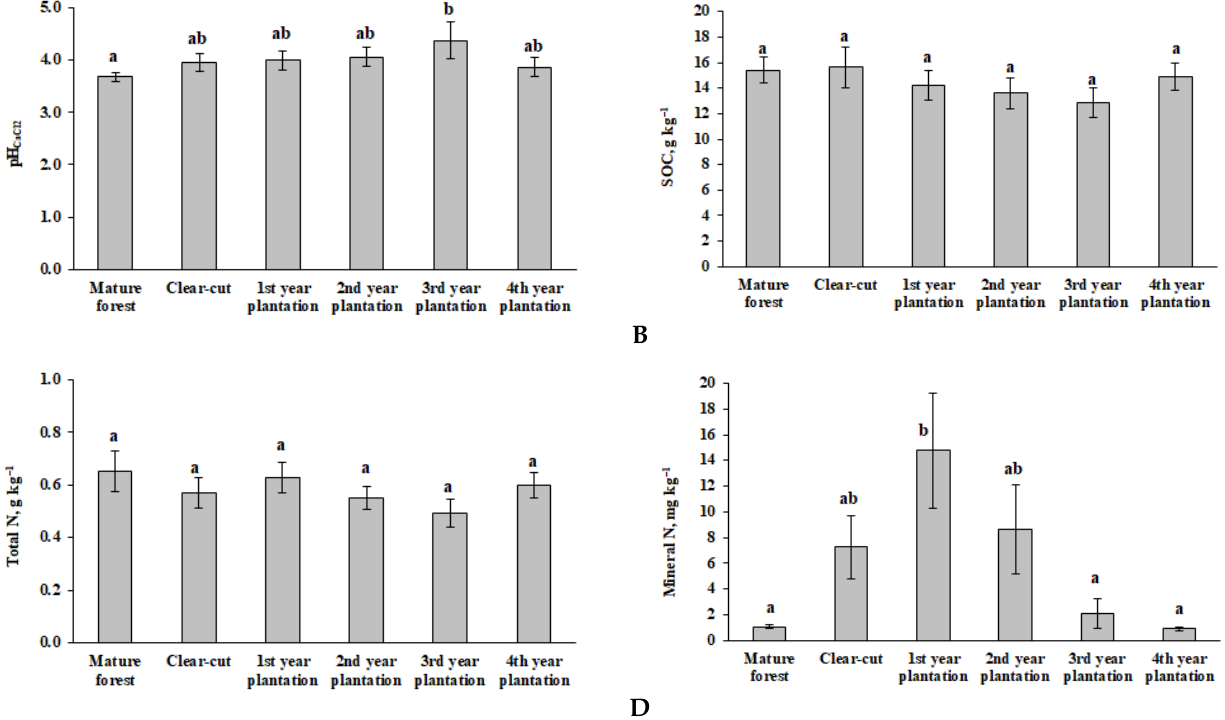
Figure 2. Mean pH CaCl2 ( A ), mean concentrations of soil organic carbon (SOC, g kg –1 ) ( B ), total nitrogen (Total N, g kg –1 ) ( C ), and mineral nitrogen (Min N, g kg –1 ) ( D ) in the 0–20 cm topsoil layer in the mature forest, clear-cut, and reforested 1st–4th year Pinus sylvestris L. plantations. The data from three study sites (A, L, and V) were combined. The values followed by the same letter indicate no significant difference between the sampling sites at p < 0.05. Table 2. Mean EC (mS m –1 ), mean concentrations of total phosphorus (P), potassium (K), calcium (Ca), magnesium (Mg), chlorides (Cl – ) (mg kg –1 ), and P 2 O 5 , K 2 O, Ca 2+ , and Mg 2+ in the 0–20 cm topsoil layer in the mature forest, clear-cut, and reforested 1st–4th year Pinus sylvestris L. plantations. The data from three study sites (A, L, and V) were combined. The values followed by different letters a and b within each column indicate statistically significant differences between the sampling sites at p < 0.05.